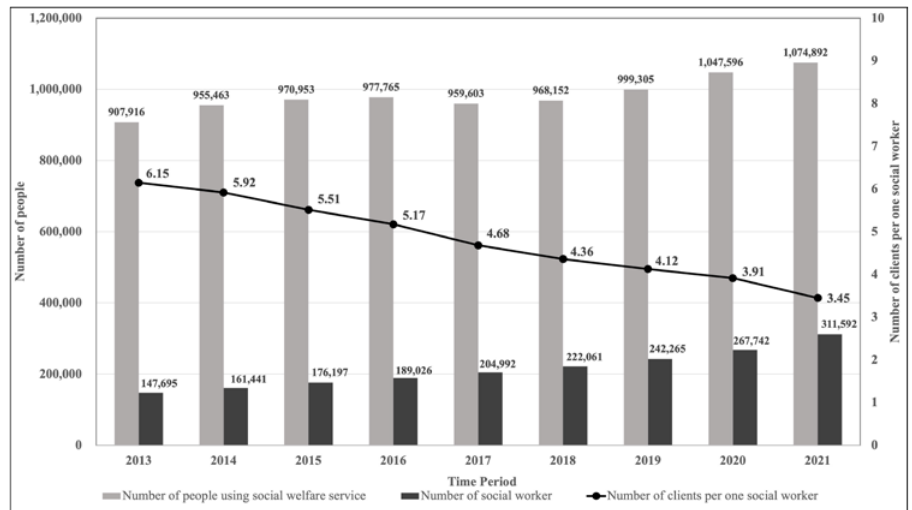
Figure 1. Number of clients per one social worker.